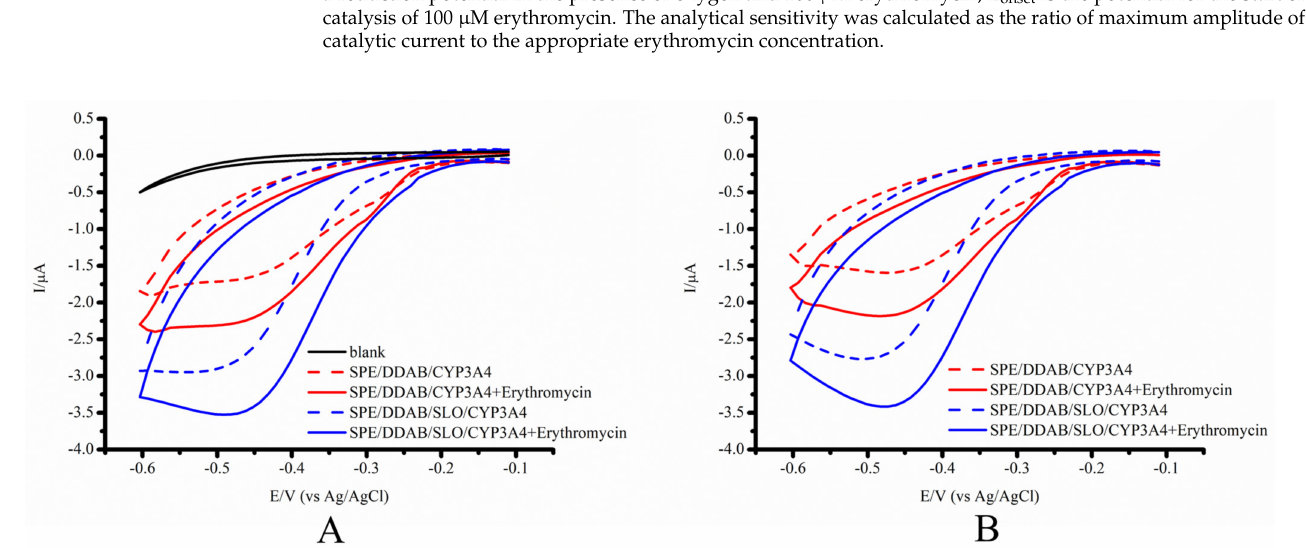
Figure 3. ( A ) CVs of SPE/DDAB, SPE/DDAB/CYP3A4, SPE/DDAB/CYP3A4 in the presence of substrate erythromycin as 100 µ M; SPE/DDAB/SLO/CYP3A4, SPE/DDAB/SLO/CYP3A4 in the presence of substrate erythromycin as 100 µ M at a scan rate of 0.1 V/s. ( B ) CVs of SPE/DDAB/CYP3A4, SPE/DDAB/CYP3A4 with 100 µ M erythromycin, SPE/DDAB/SLO/CYP3A4, SPE/DDAB/SLO/CYP3A4 with 100 µ M erythromycin, at a scan rate of 0.1 V/s with the background subtracted